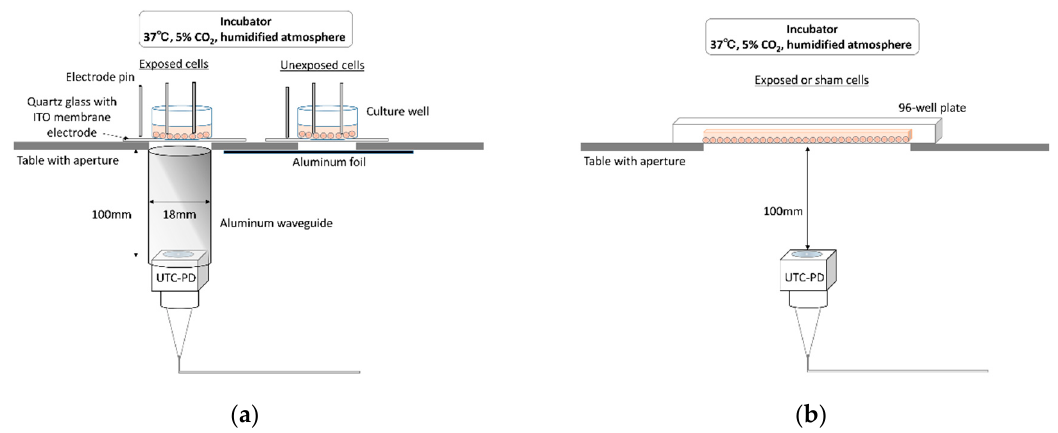
Figure 1. Scheme of the exposure set-up showing the terahertz (THz) wave source in the incubator chamber for measuring cell proliferation ( a ) and cell viability ( b ).